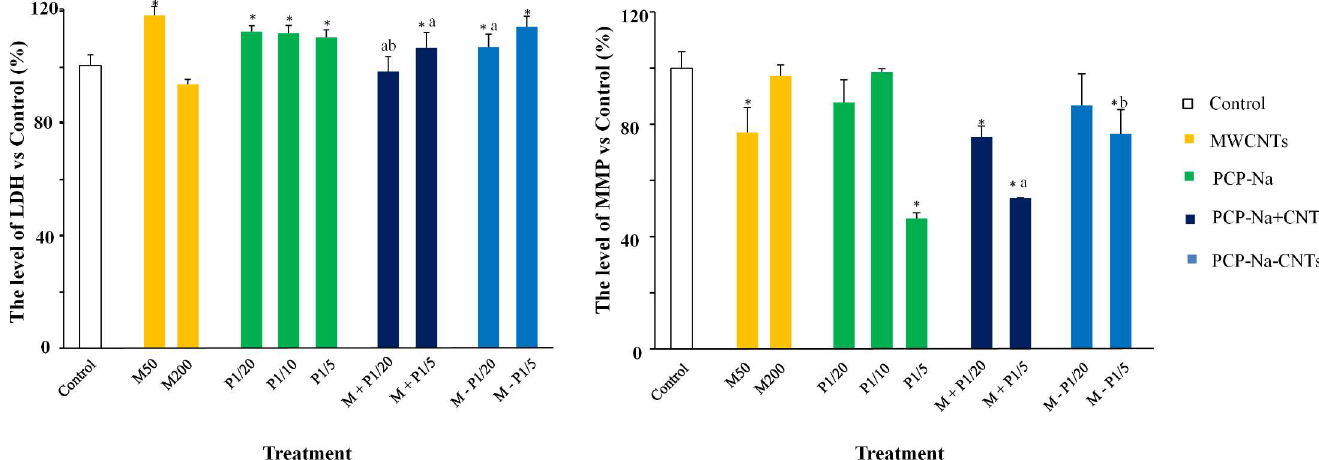
Fig 3. Activities of antioxidantenzymes of the earthworm coelomocytes after exposure to different treatments of MWCNTs (M), PCP-Na (P), and their complex(A) LDH, (B) MMP. Data are expressedas the mean ± standarddeviation(SD) of quadruplicateanalyses. * means which has a significant difference from the control (CK), a means the complex group which had significantdifference from M50, b means the complex group which had significant difference from corresponding P1/20 or P1/5 ( p < 0.05).